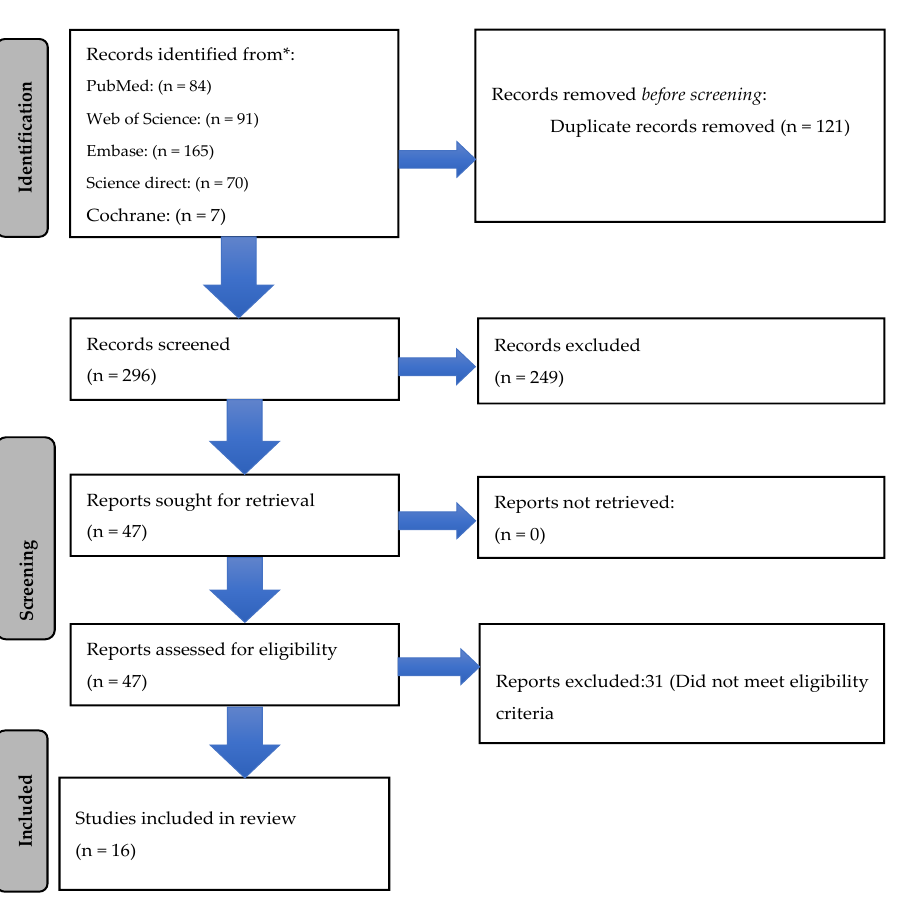
Figure 1. Prisma flow chart depicting studies including cefoperazone/sulbactam alone and in com- bination.